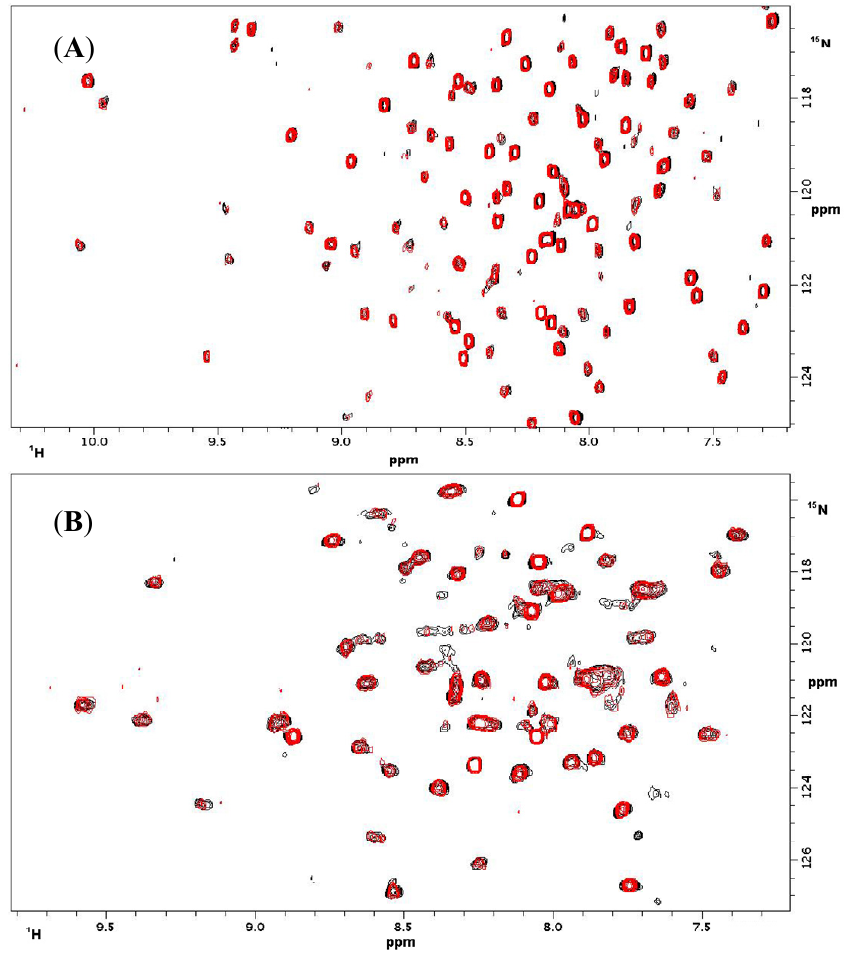
Figure 3. ( A ) Superposition of NMR spectra of rat NKR-P1A with (red) and without (black) p NP-GlcNAc; ( B ) Superposition of NMR spectrum of human CD69 with (red) and without (black) p NP-GlcNAc.